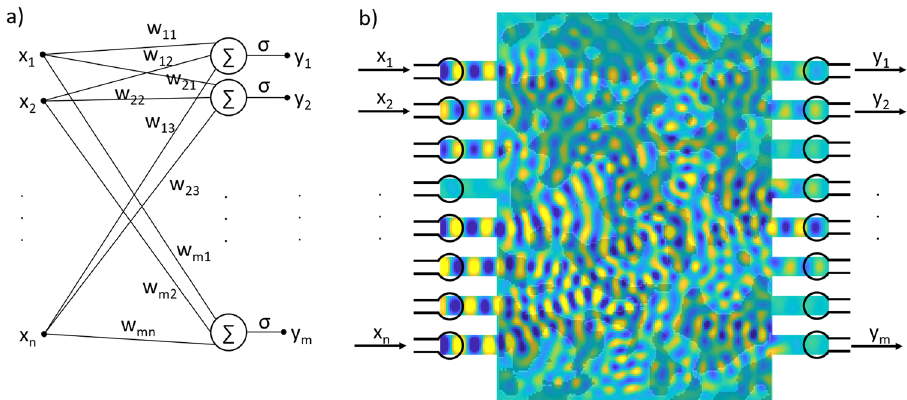
Fig. 5 Understanding the spin-wave scatterer as a neural network. a Is a schematic of an n -input, m -output perceptron layer ( b ) is an n -input, m -output